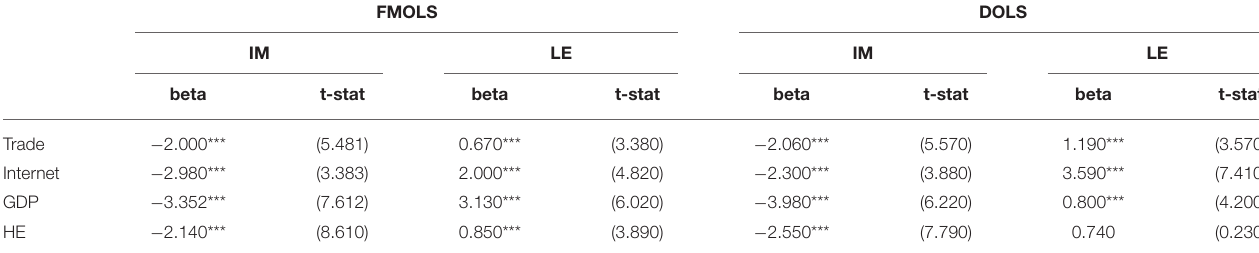
TABLE 4 | Panel estimates of FMOLS and